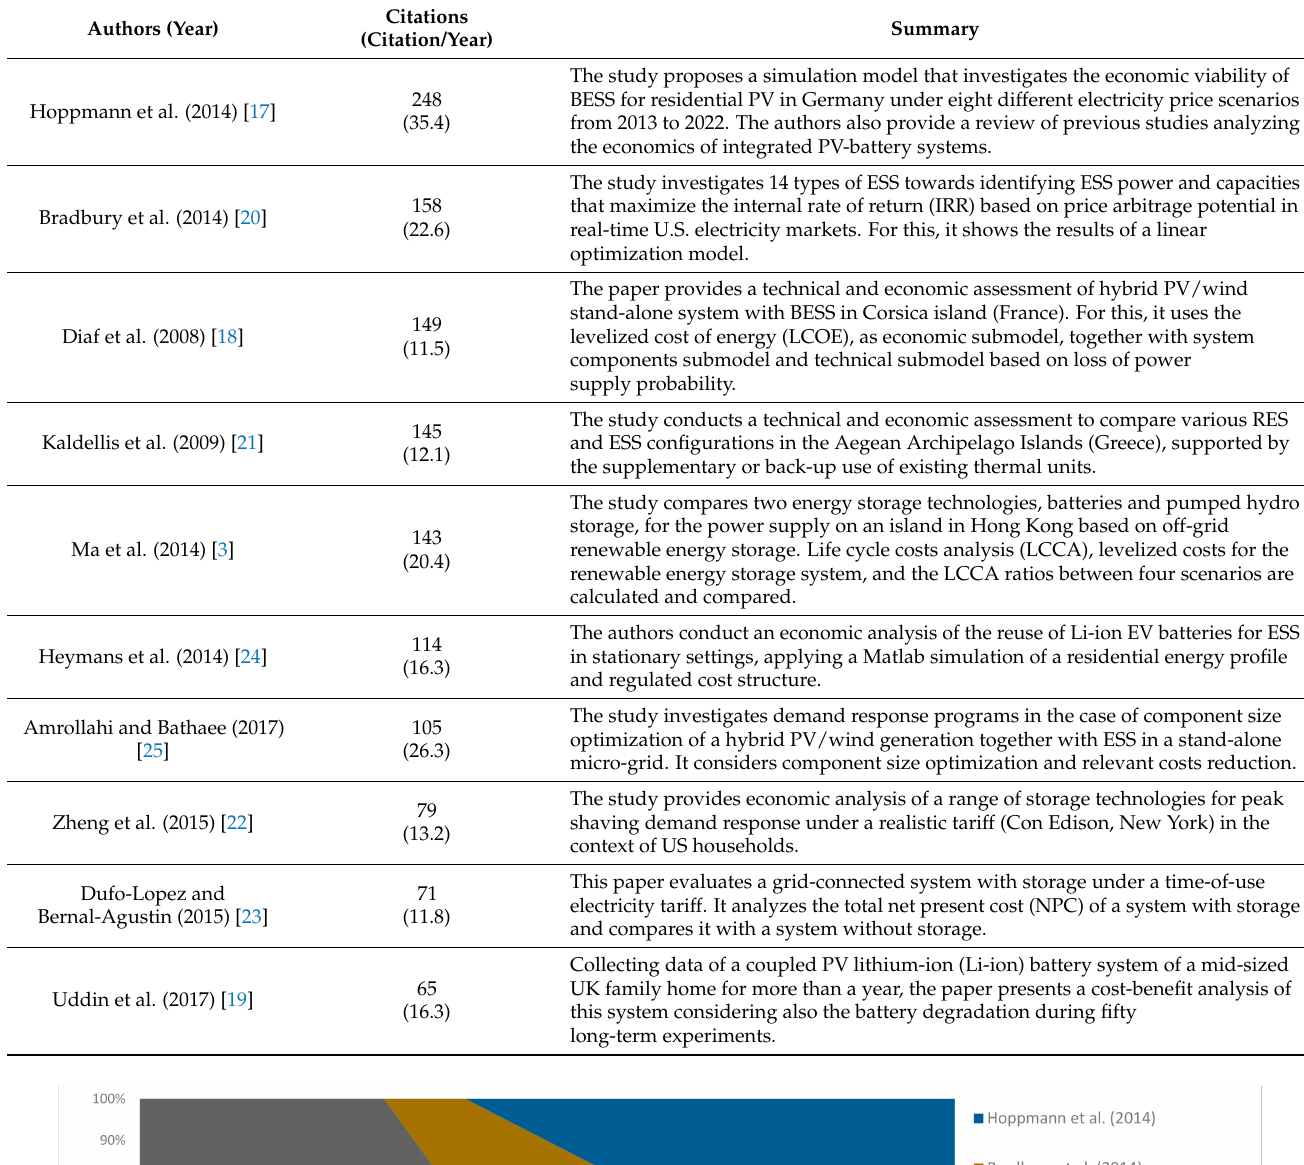
Table 1. Summary table of the most cited articles in the analyzed sample.